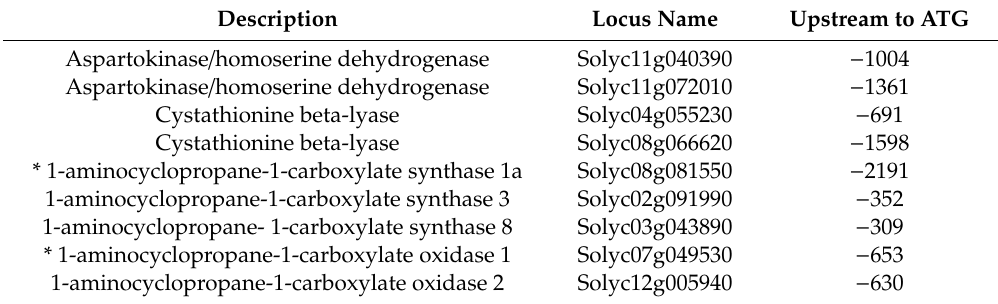
Table 3. The position of methionine and ethylene biosynthetic genes with an AtSR1-binding motif in the promoter region. Description Locus Name Upstream to